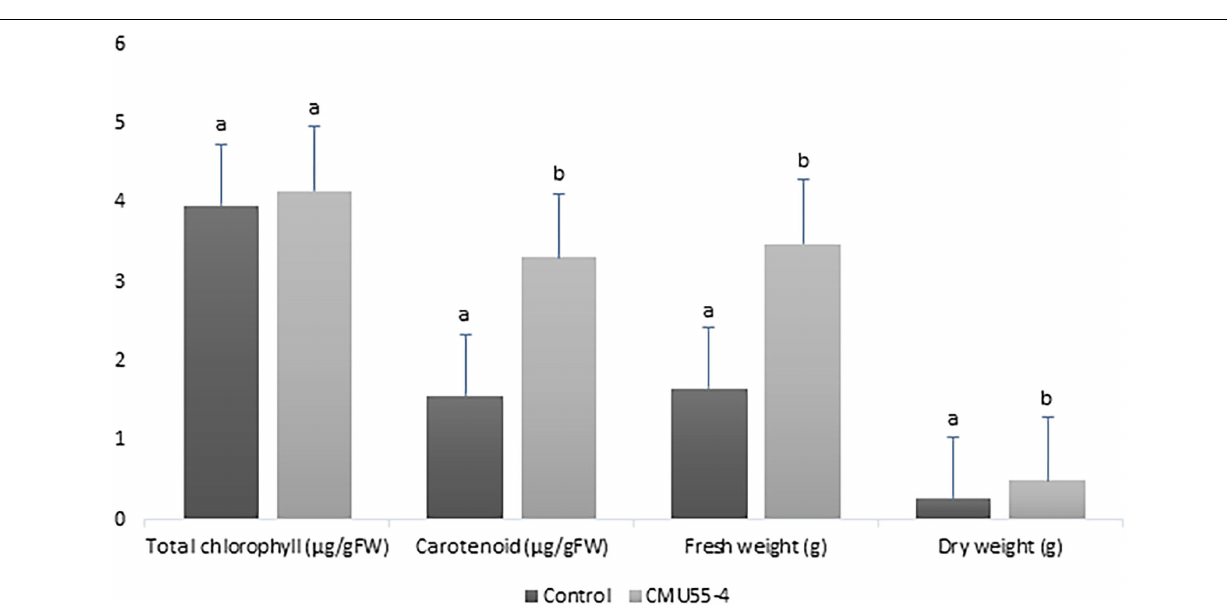
FIGURE 2 | P. sphaericum control plant (A) and P. sphaericum inoculated with CMU55-4 for 1 month (B) . Arrows indicated capsule production.